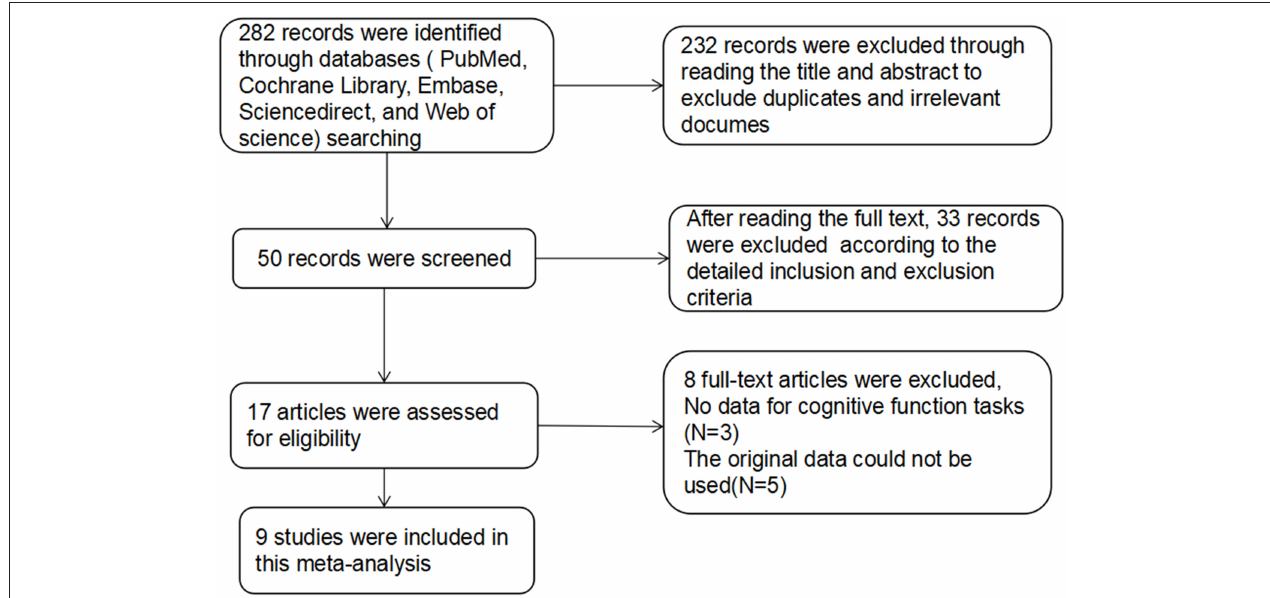
FIGURE 1 | Document screening process and results.